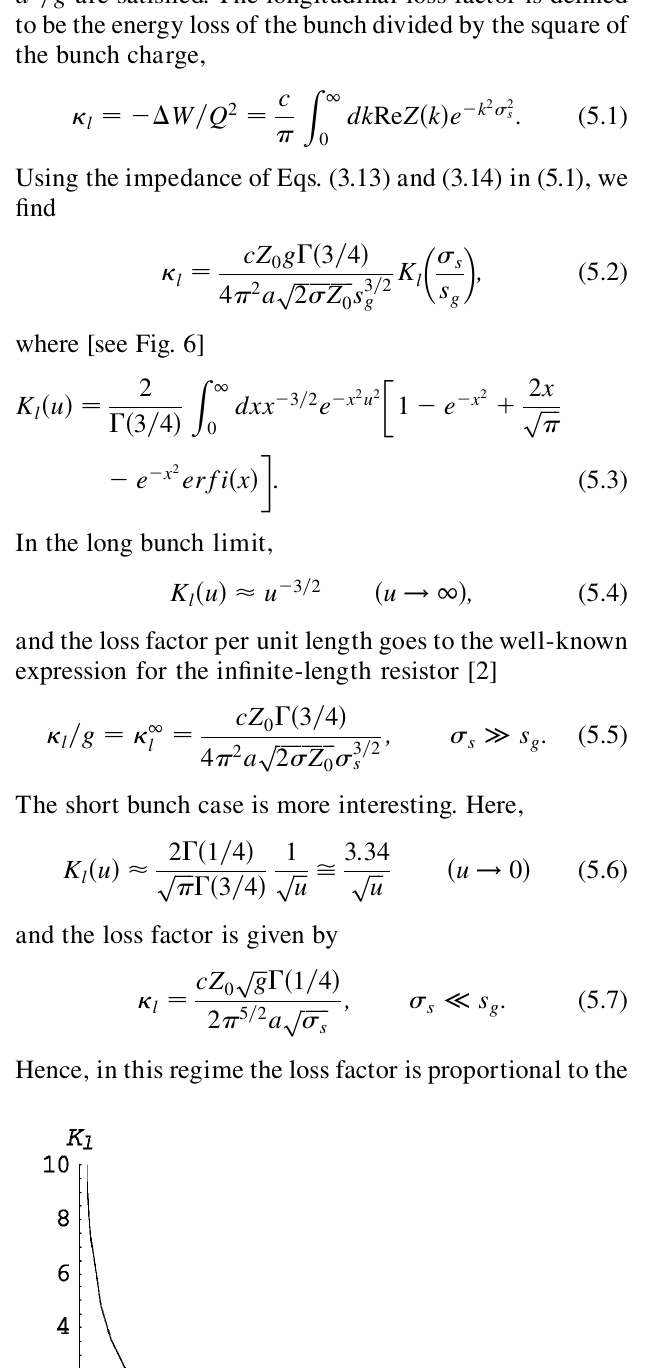
FIG. 6. The function K